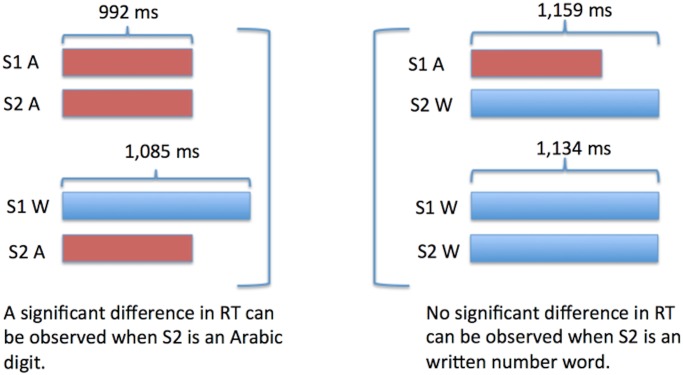
A = Arabic digit & W = written number word.This figure demonstrates how the longer encoding time of W at S2 would mask RT differences if S1 retrieval and S2 encoding occurred in parallel. In the AW condition, even though A may be retrieved more quickly, the participant would not be able to answer until W had been encoded which would make the RT observed indistinguishable from the WW condition.